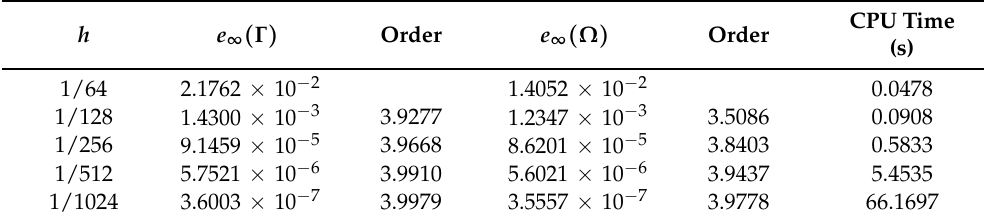
Table 3. Numerical convergence orders of the fourth-order fast algorithm with k 0 = 16 π m − 1 , ε r = 4 +